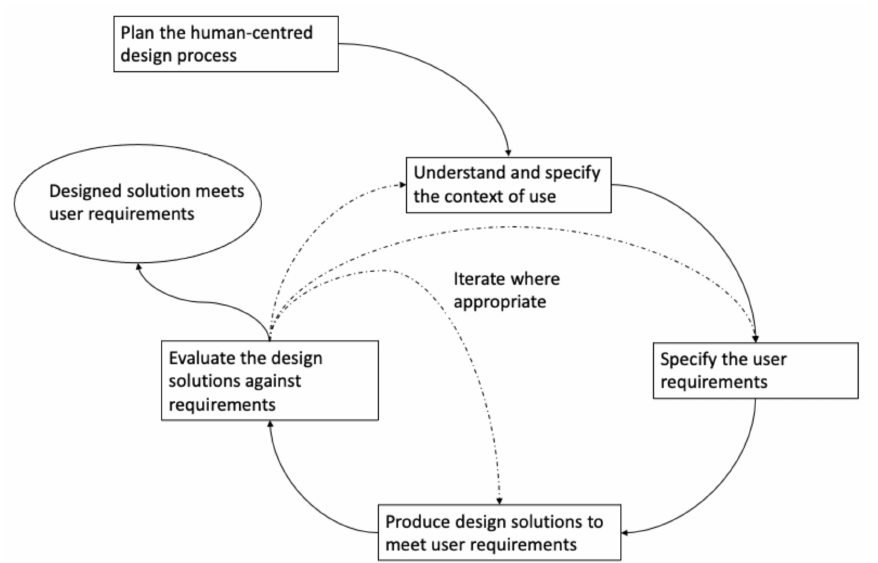
Figure 1. Human-centred design process based on ISO 9241-210 Ergonomics of human–system interaction—Part 210: Human-centred design for interactive systems. The solid lines represent transitions that must occur and the dotted lines are transitions that may occur depending on how the processes